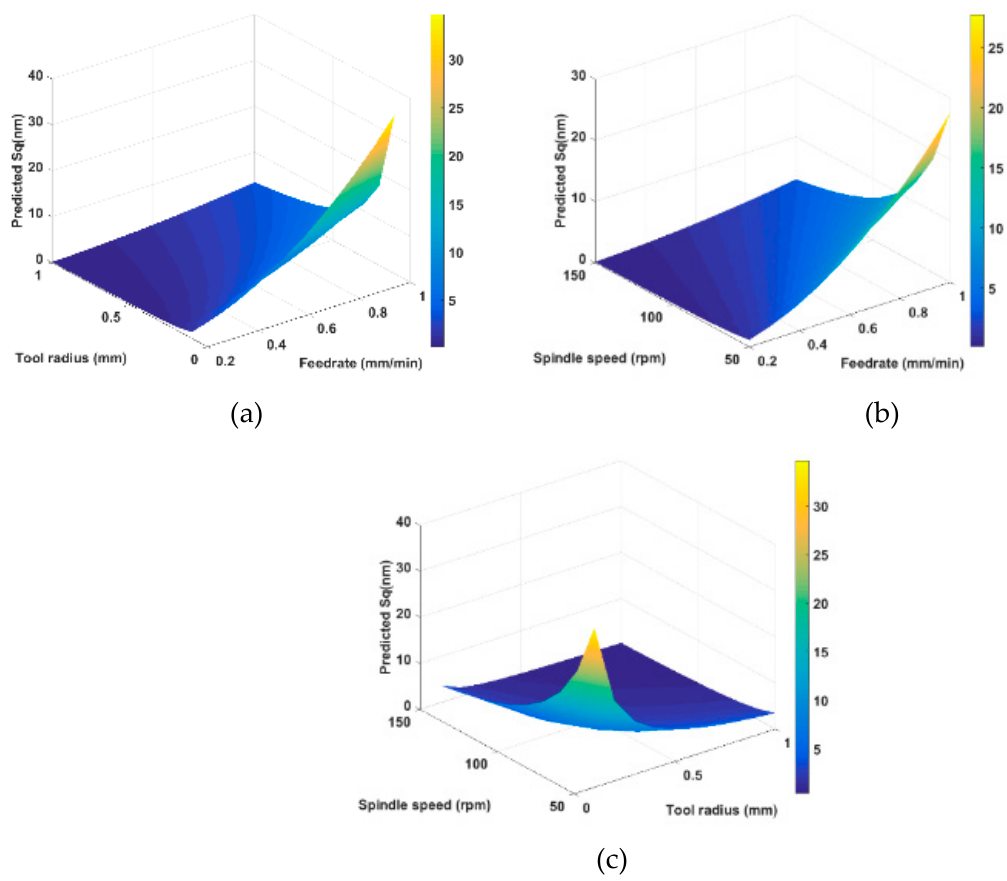
Figure 15. Relationship graphs between processing parameters and surface quality: ( a ) R c and f vs. S q ( S = 100 rpm); ( b ) S and f vs. S q ( R c = 0.5 mm); ( c ) S and R c vs. S q ( f = 0.6 mm/min).